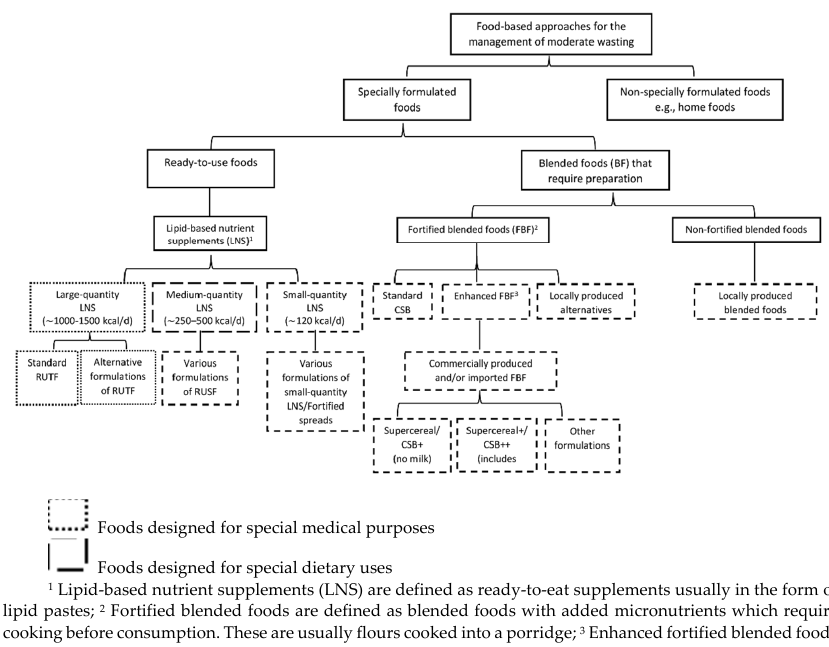
Figure 2. Flowchart of intervention categories.